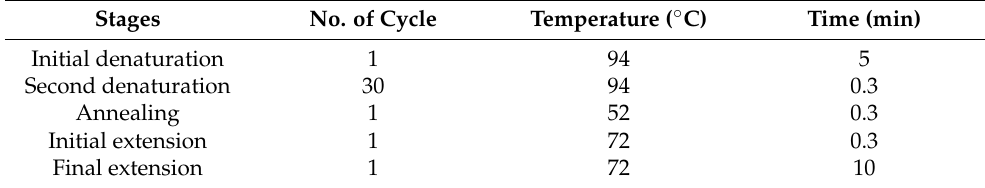
Table 2. Amplification programs of PCR